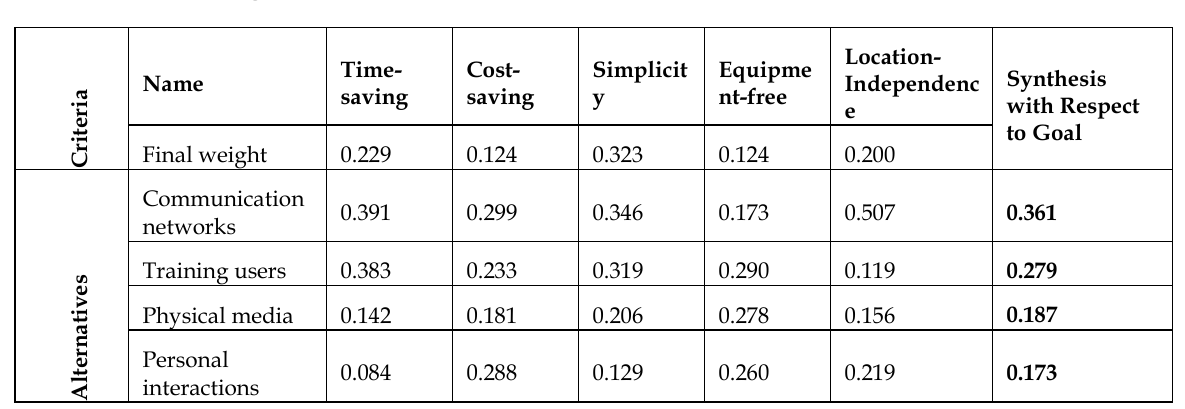
Table 3 Matrix table comparing criteria versus